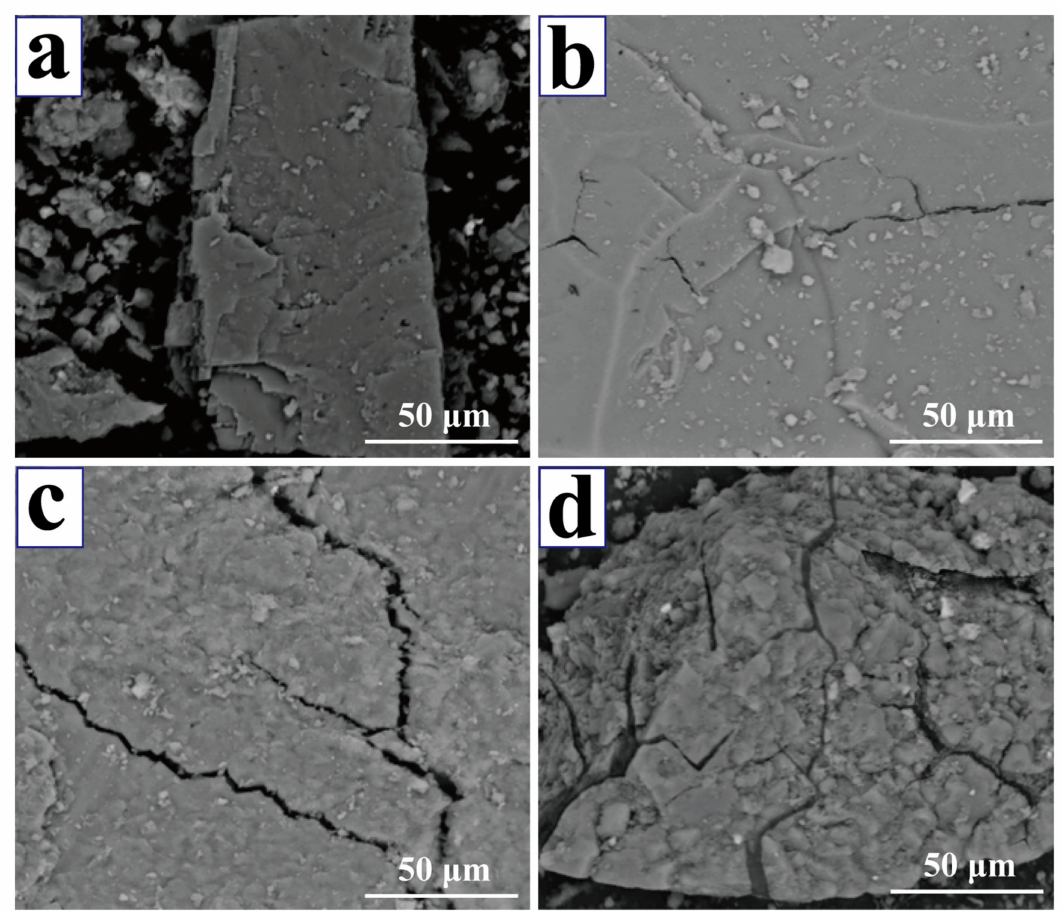
Figure 8. SEM images of ore and calcine at ventilatory volume: ( a ) raw ore; ( b ) roasted at 0.2 m 3 /h; ( c ) roasted at 0.6 m 3 /h; ( d ) roasted at 1.0 m 3